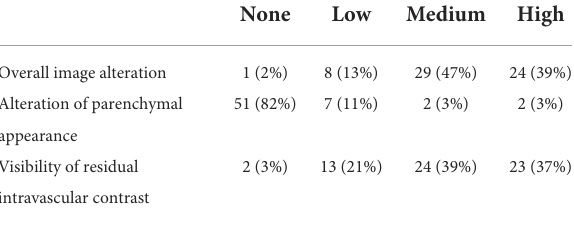
TABLE 2 Imaging alterations due to residual IV iodine contrast on non-contrast CT after CSC arrival in the transfer group ( n = 62). None Low Medium